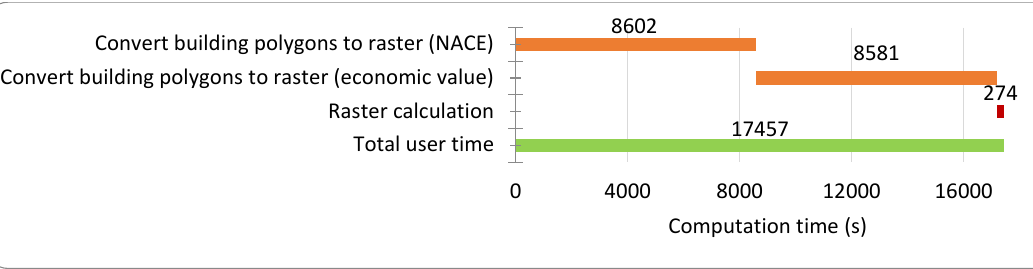
Figure 16. User time to calculate the economic damage of a coast flood event for the Belgian coast with a resolution of 1 m.